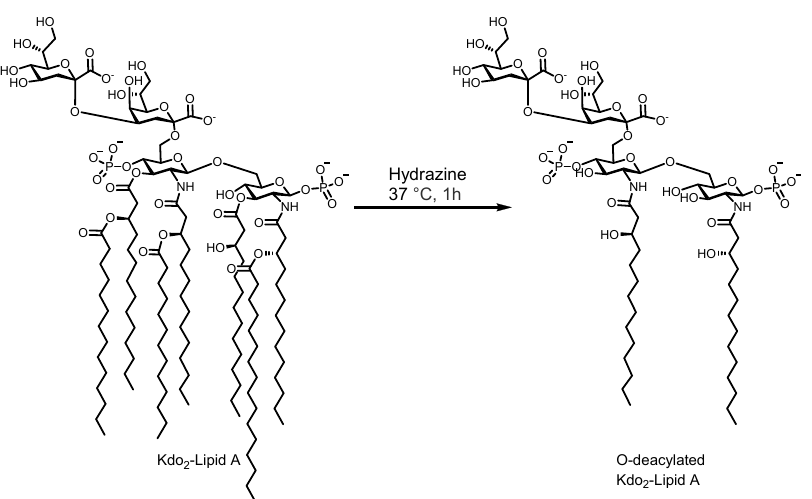
Figure 3. Reaction of Kdo 2 -Lipid A with hydrazine to selectively remove O-attached acyl